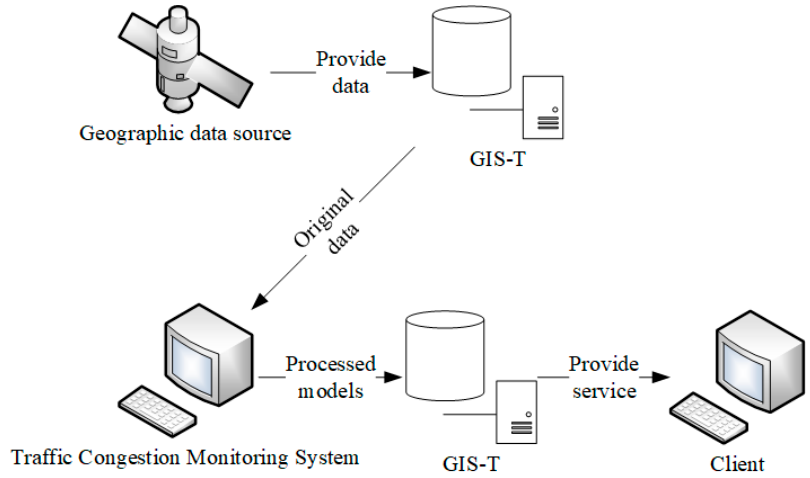
Figure 1. The data processing flow between Geographic Information System for Transportation (GIS-T) and the tra ffi c congestion monitoring